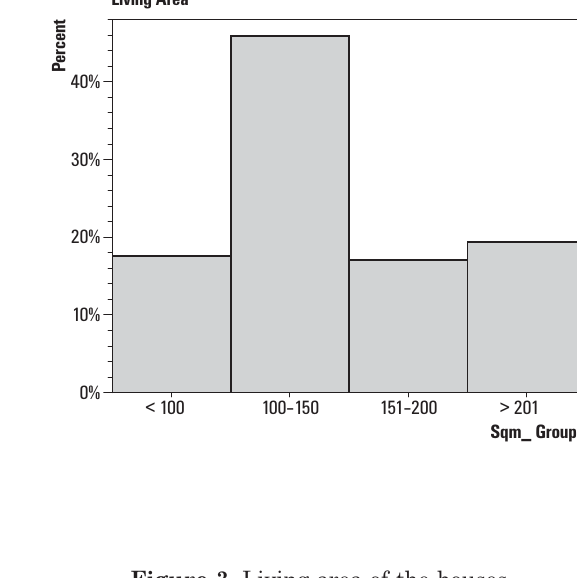
Figure 3. Living area of the houses